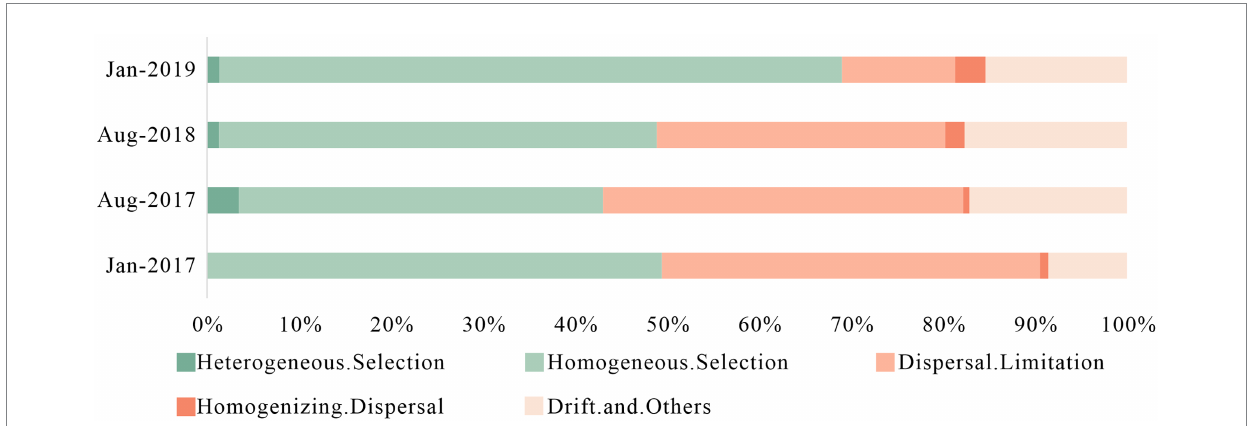
FIGURE 5 Assembly processes of bacteria community in karst river at four sampling times (Jan-2017, Aug-2017, Aug-2018, and Jan-2019) in karst river. Deterministic processes were composed of heterogeneous selection and homogeneous selection, and stochastic processes were composed of dispersal limitation, homogenizing dispersal, drift and other